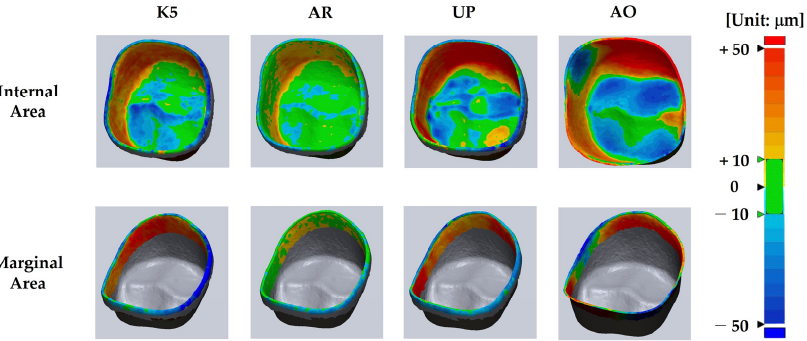
Figure 4. Representative superimposed images of the reference specimen and fabricated specimen (superimposed images of all the experimental specimens are shown in Figure S1).